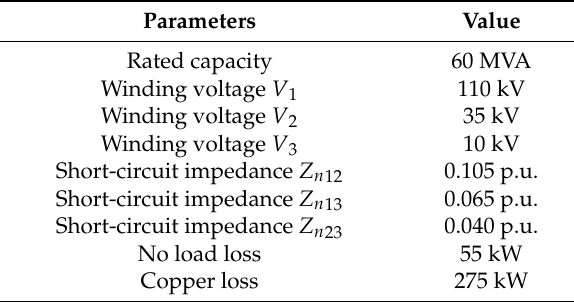
Table 1. Design parameters of the new grid-connected transformer.